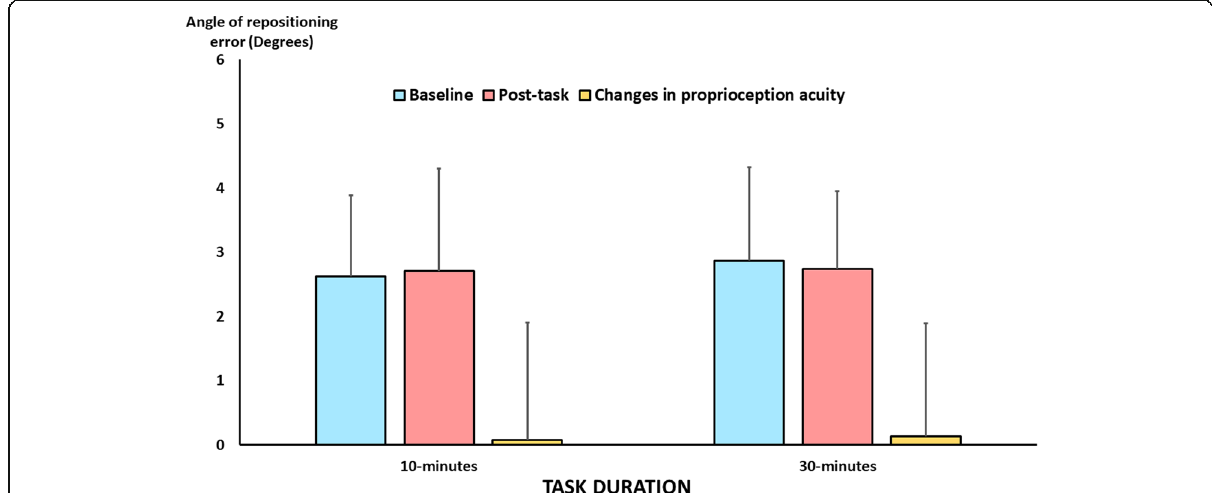
Fig. 2 Proprioception acuity as measured by angle of repositioning error (RE) is shown at baseline and after each task duration. Changes in acuity for each tested duration is also